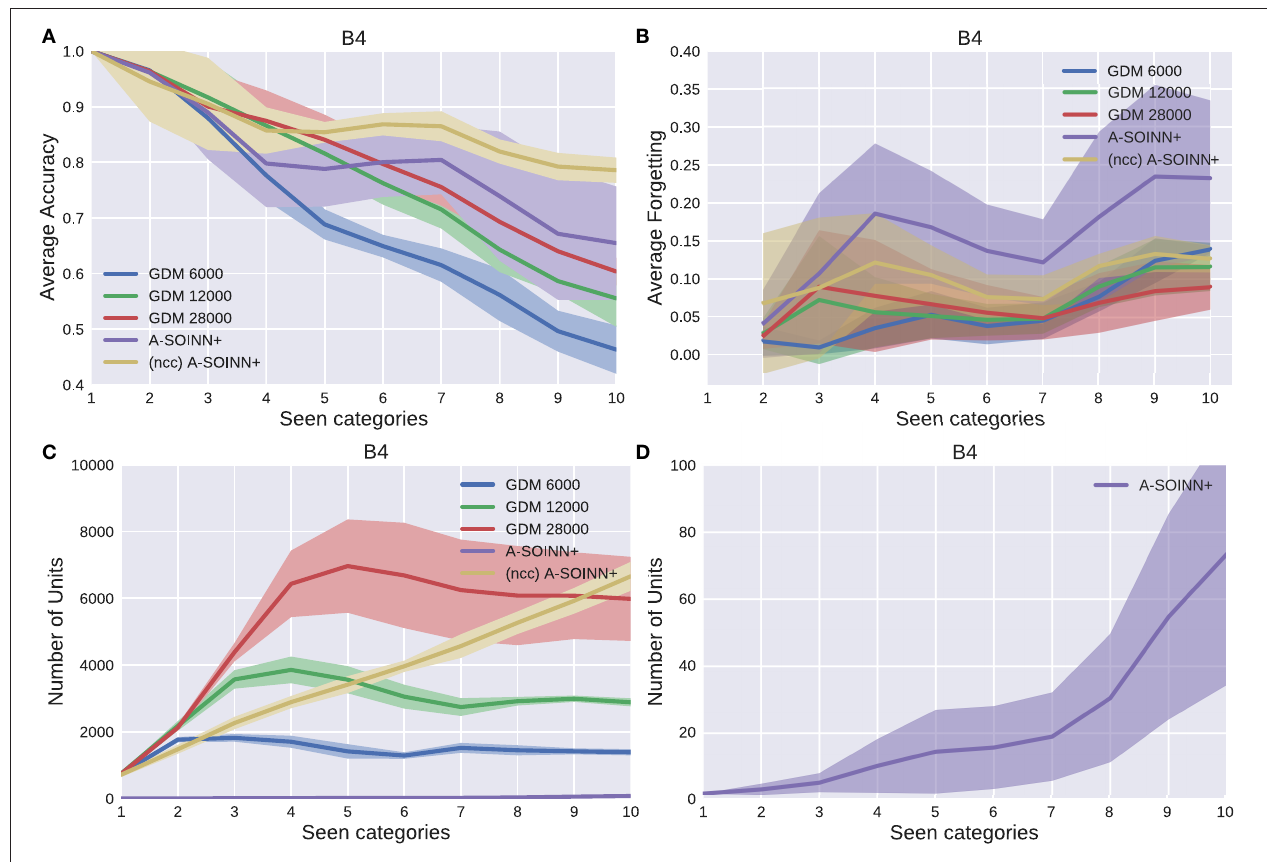
FIGURE 8 | The results of the fourth experiment. For further descriptions, see Figure 5